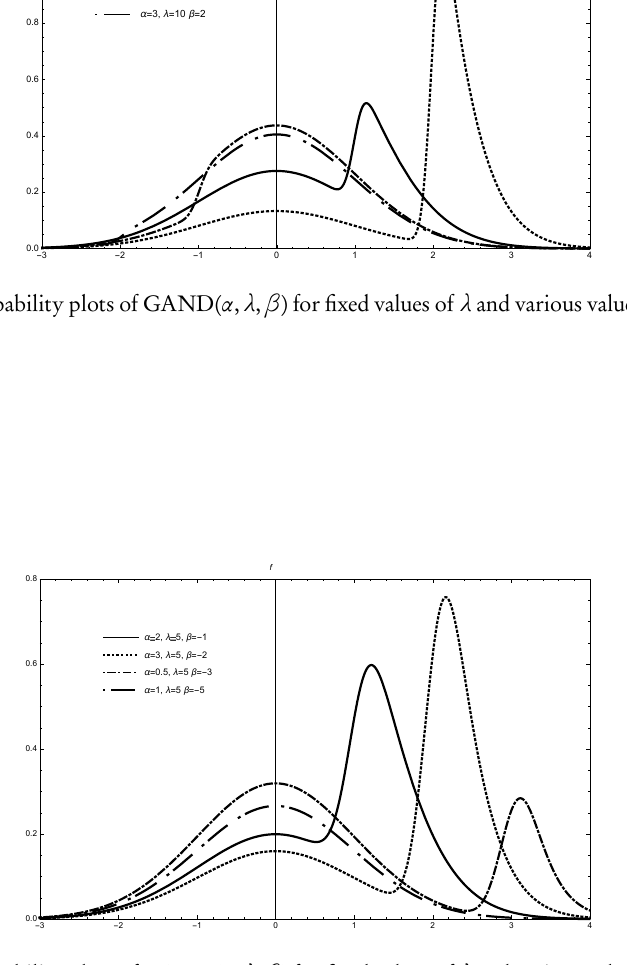
Figure 2 – Probability plots of GAND( α , λ , β ) for fixed values of λ and various values of α and β